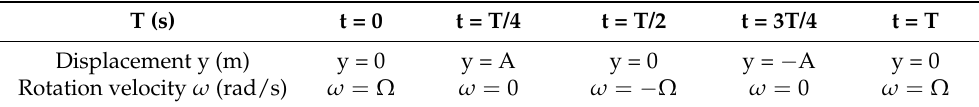
Table 2. The corresponding values of vibration displacement and rotation velocity at one period.